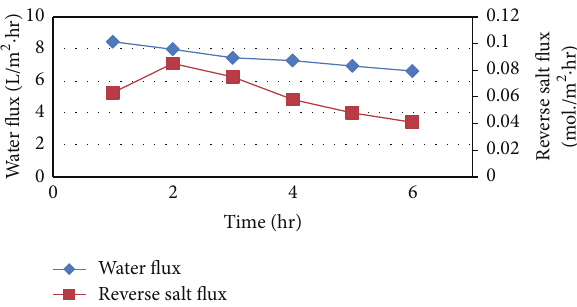
Figure 5: Water and reverse solute fluxes as a function of time (1st stage of FO-batch